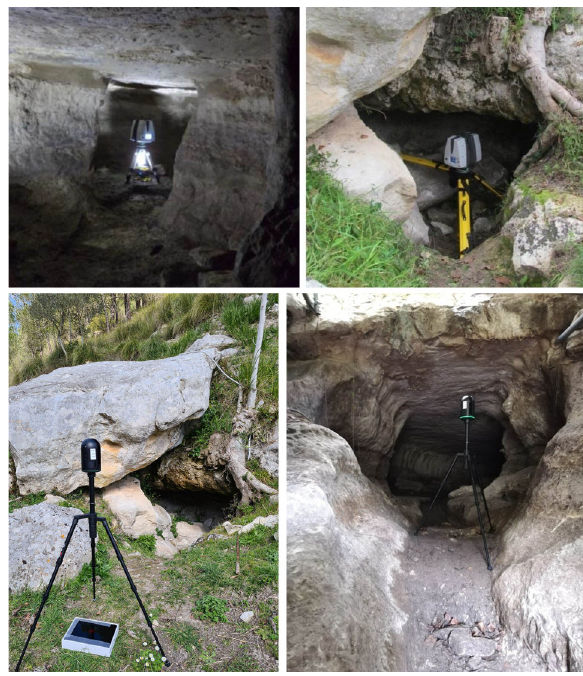
Figure 6 . On site acquisition: top, 2017-19; down, 2021.